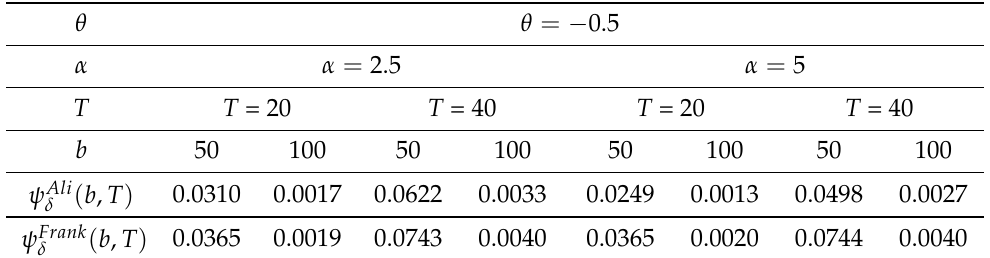
Table 3. Asymptotic ruin probability for non-homogeneous Poisson risk model with interest rate. θ θ = − 0.5 α =